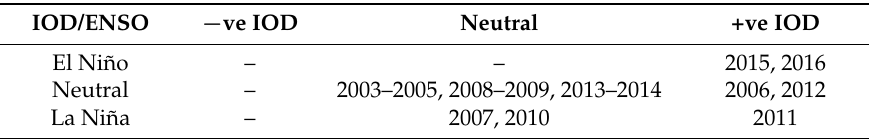
Table 2. Classification of years when El Niño or La Niña and/or positive or negative Indian Ocean dipole occurred.